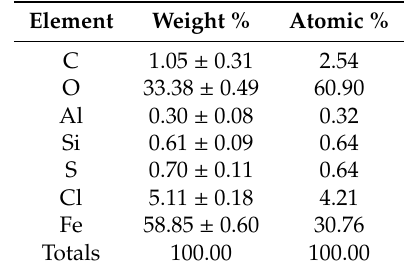
Table 1. Quantitative results of the weight and atomic concentration of selected elements on the basis of EDX presented in Figure 3.